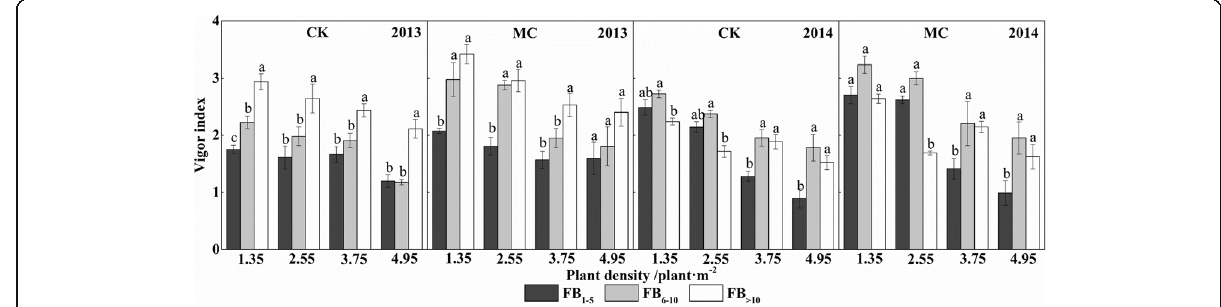
Fig. 3 Vigor index of cottonseed at different fruiting branches as affected by plant density and MC in Sikang 1 in 2013 and